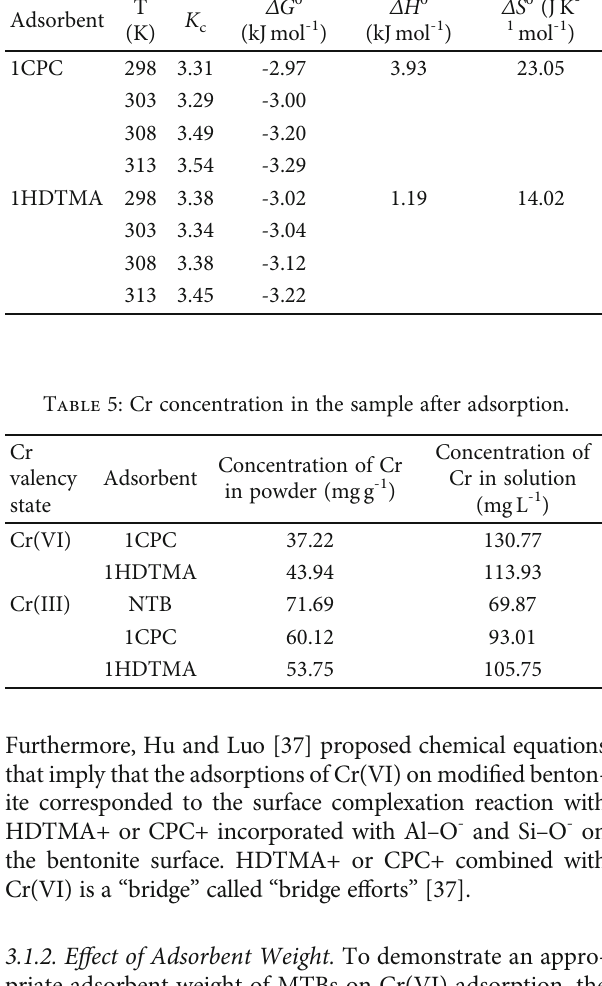
Table 4: Parameters of the thermodynamic adsorption analysis. T Adsorbent